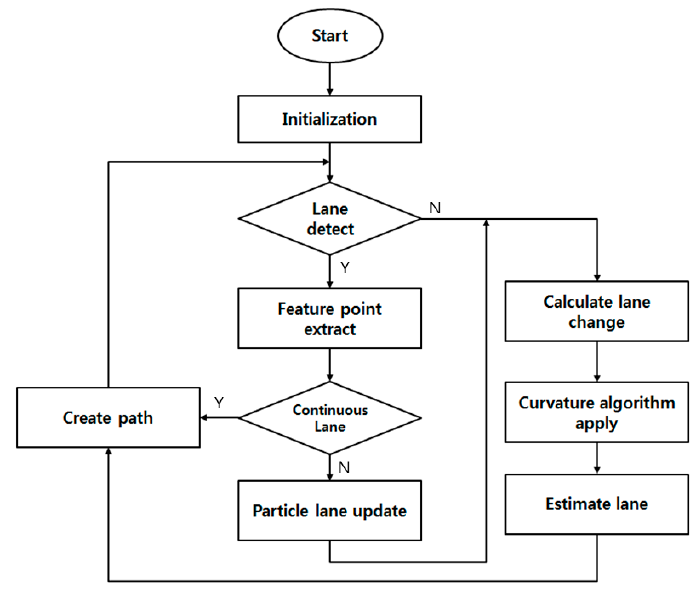
Figure 9. Total system flow.